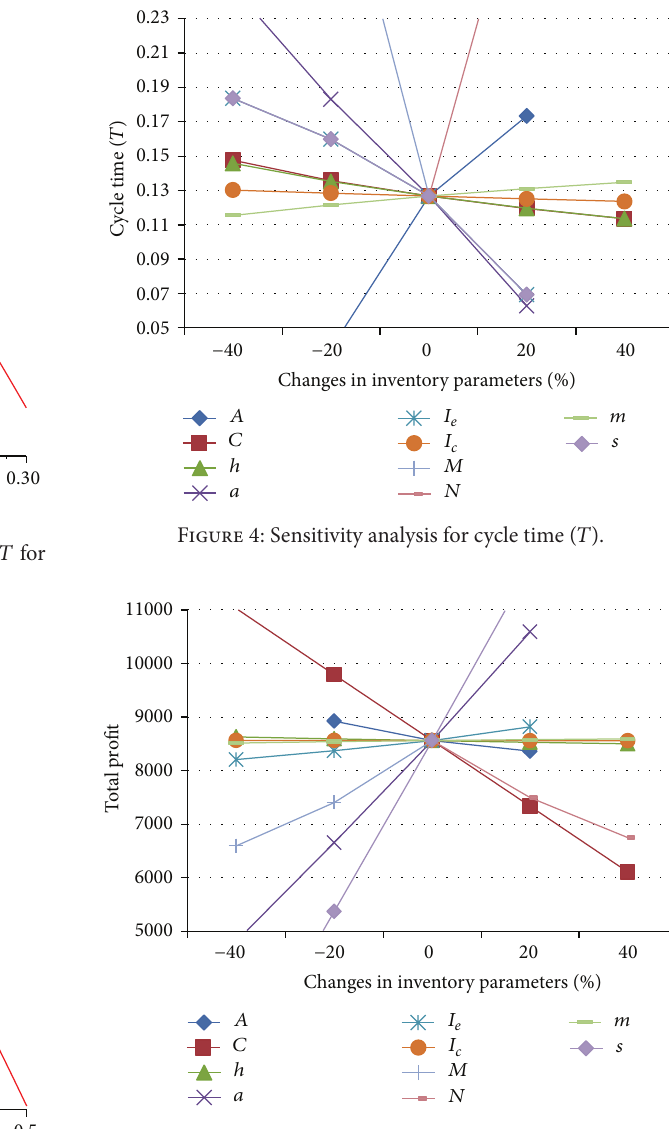
Figure 5: Sensitivity analysis for total